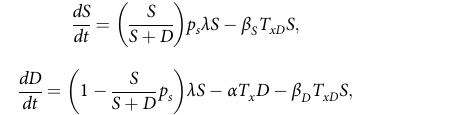
(P) (Fig. 9). PCaSCs divide with rate λ (day − 1 ) to produce either a PCaSC and a non-stem PCa cell with probability 1 − p s (asymmetric division) or two PCaSCs at probability p s (symmetric division) with negative feedback from differentiated cells 16 , modeled as S . Differentiated cells exclusively produce PSA at rate ρ (µg/L S þ D day − 1 ), which decays at rate φ (day − 1 ). Unlike androgen-independent PCaSCs, differentiated cells die in response to androgen removal at rate α (day − 1 ) 41 . IADT on and off cycles are described with parameter T x , where T x = 1 when IADT is given and T x = 0 during treatment holidays.